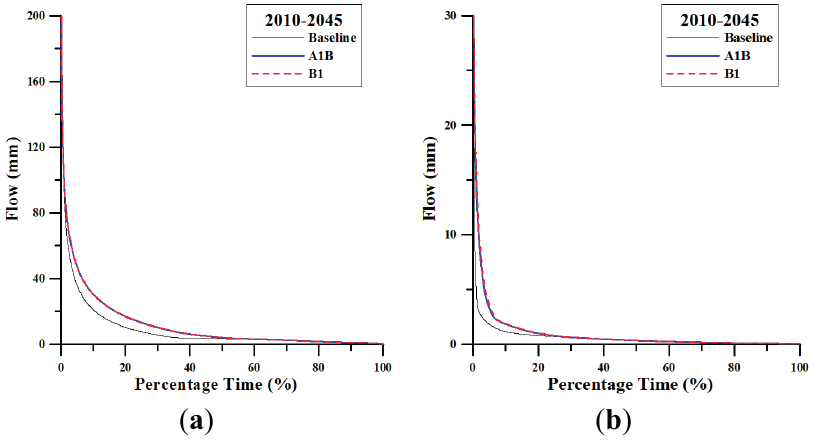
Figure 6. Flow duration curves of the ( a ) wet season and ( b ) the dry season during the baseline period and the future period